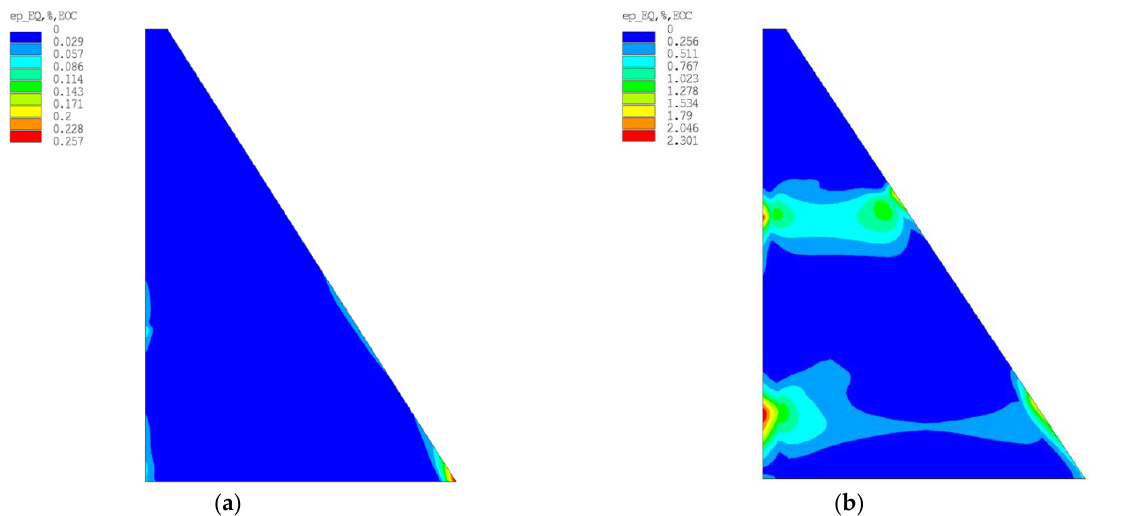
Figure 15. Results of calculation of plastic deformation in concrete mass at the time of completion of construction with: ( a ) The most favorable design case; ( b ) The least favorable calculation